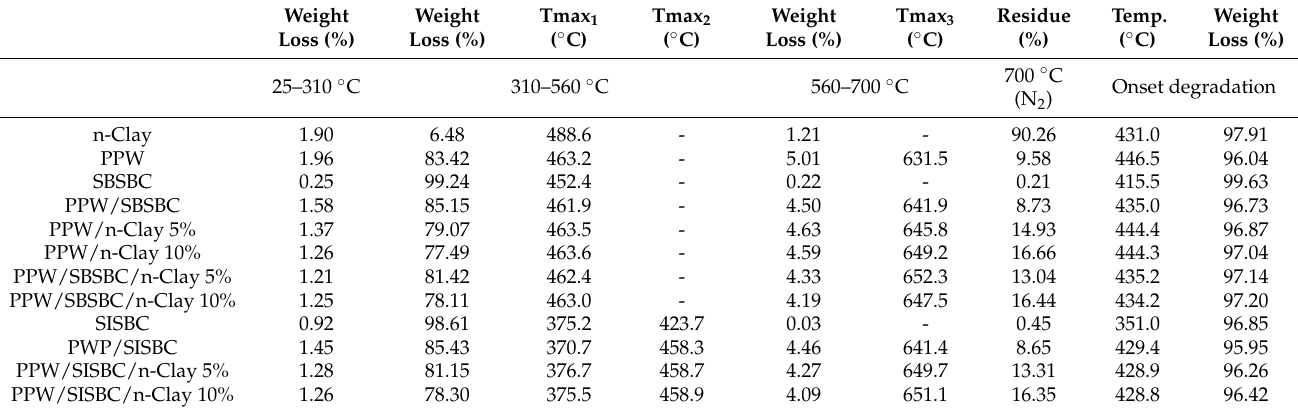
Table 6. Thermal parameters evaluated from TGA